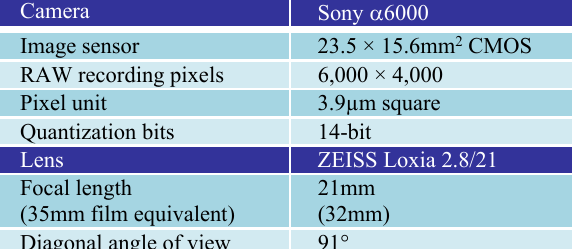
Table 1. Specifications of camera and lens of Dataset